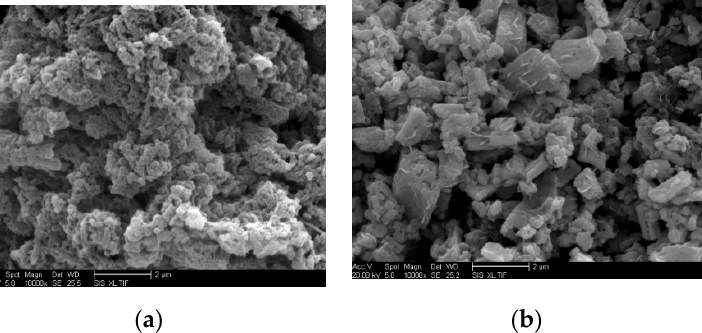
Figure 4. Scanning electron microscopy (SEM) photographs of prepared materials. ( a ) PANI; ( b ) PANI/SnO 2 .